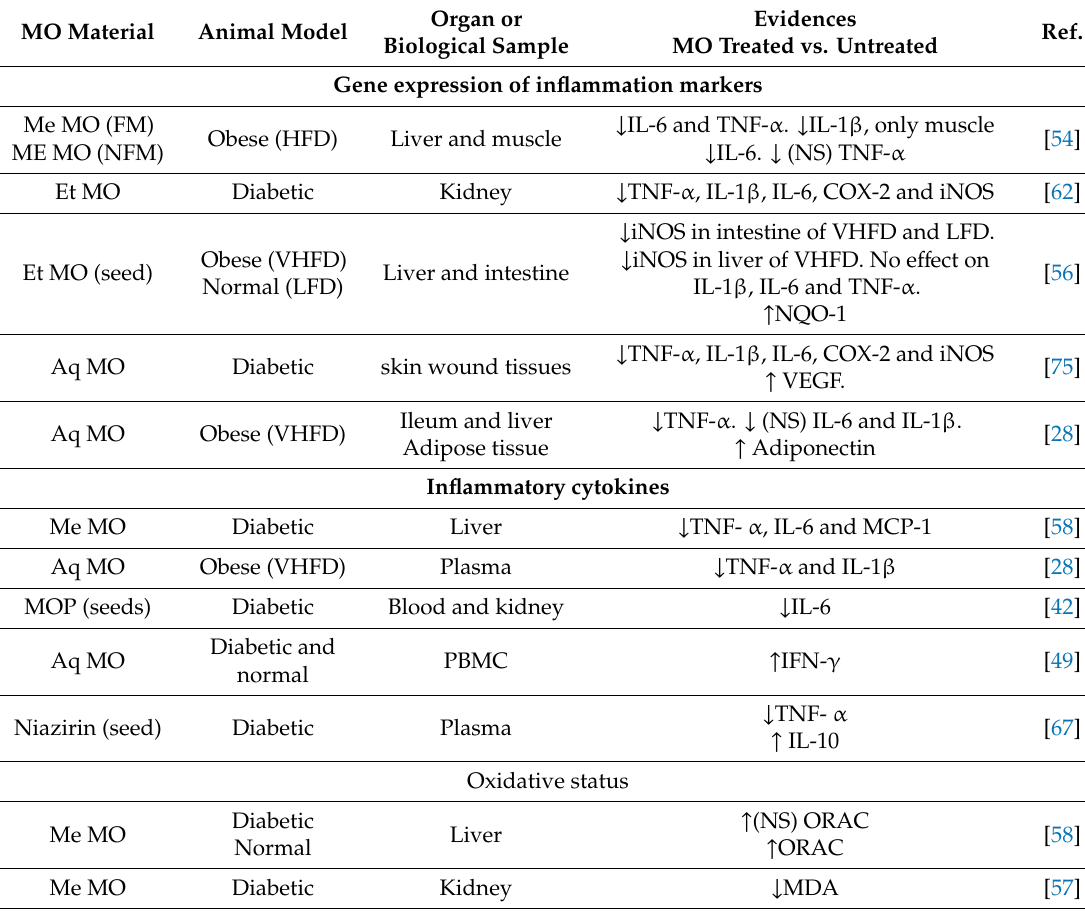
Table 3. Effects of M. oleifera on antioxidant capacity and inflammation protection in diabetic animal models. Organ or MO Material Animal Model